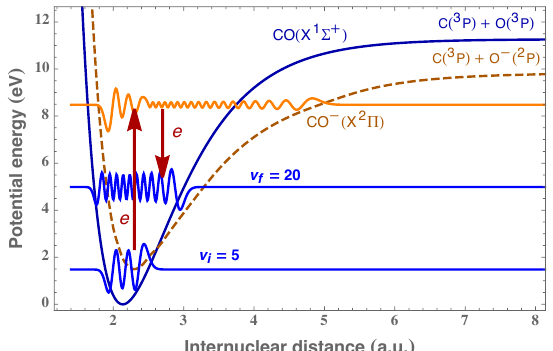
Figure 7. Schematic representation of the vibrational excitation process by electron impact in the case of a CO molecule: in blue, the initial ( v i = 5) and final ( v f = 20) vibrational wave functions of CO are represented. The resonant CO − wave function is reported in